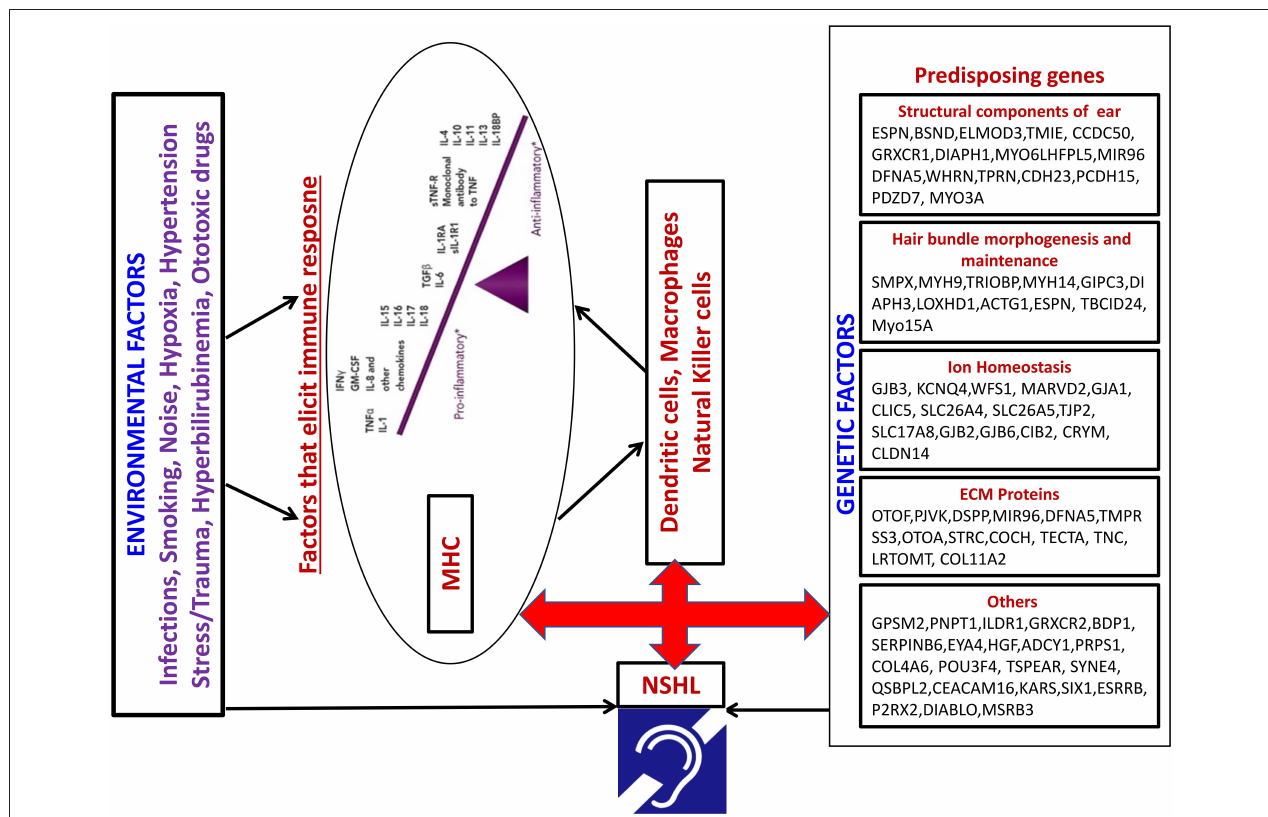
FIGURE 2 | Model depicting the possible interaction between Environmental factors and pre-disposing NSHL genes through immune mediated pathway.